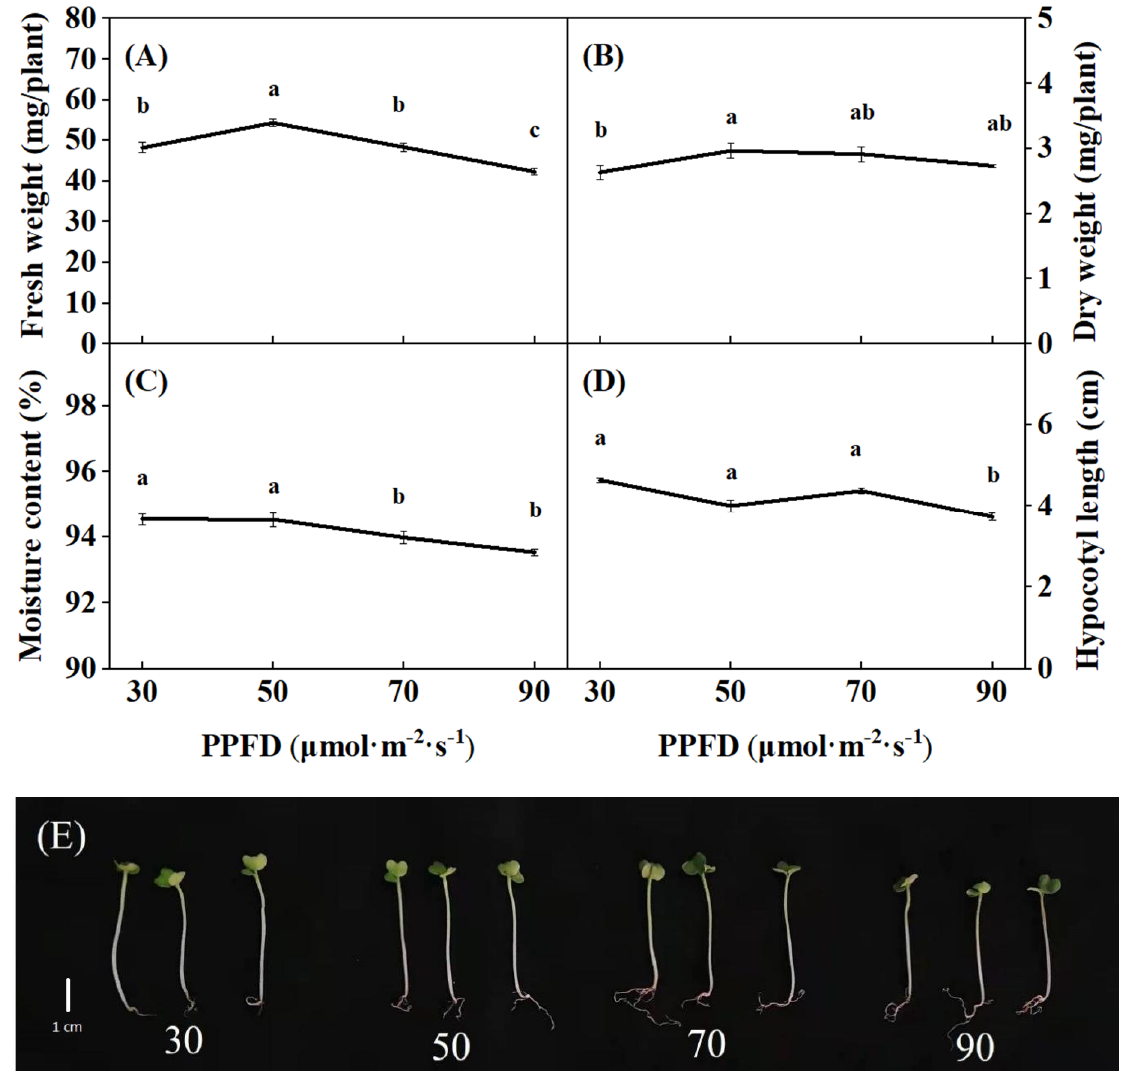
Figure 3. Fresh weight ( A ), dry weight ( B ), moisture content ( C ), and hypocotyl length ( D ) of broccoli microgreens response to different light intensity treatments. The lowercase letters in all figures represent the significant difference ( p < 0.05). Vertical bars indicate the means ± SE (n = 15). Photo of broccoli microgreens ( E ) was taken at 8 days after sowing, where the bar represents 1 cm.